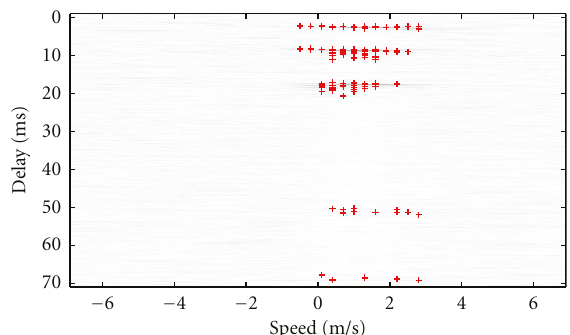
Figure 9: Wideband ambiguity function of the received OFDM signal in the KAM08 experimental data. The crosses represent the maxima detected after each MPD iteration.